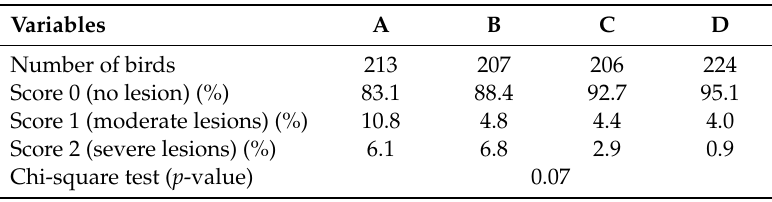
Table 4. Incidence and severity of FPD at 42 d